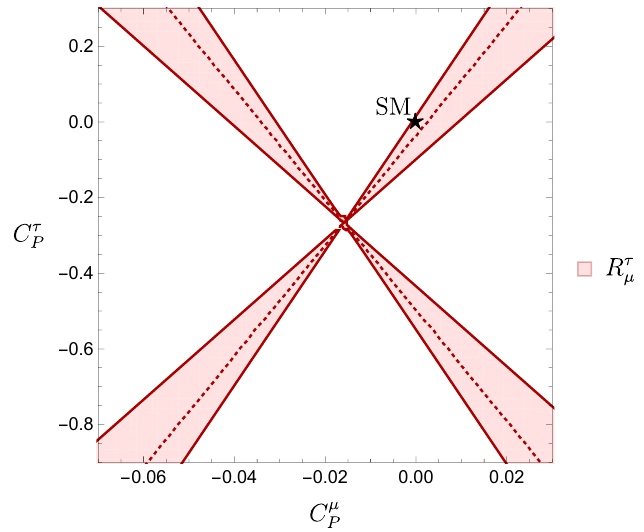
µ – C τ plane following from the leptonic ratio R τ P P